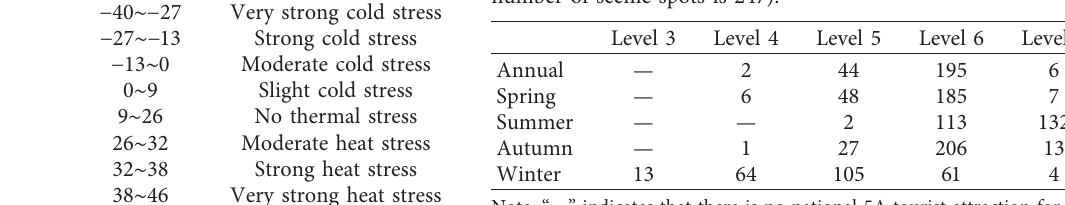
Figure 2: Spatial distribution of annual average climate comfort in the mainland of China. Table 2: The number of national 5A tourist attractions with respect to climate comfort levels in the mainland of China (the total number of scenic spots is